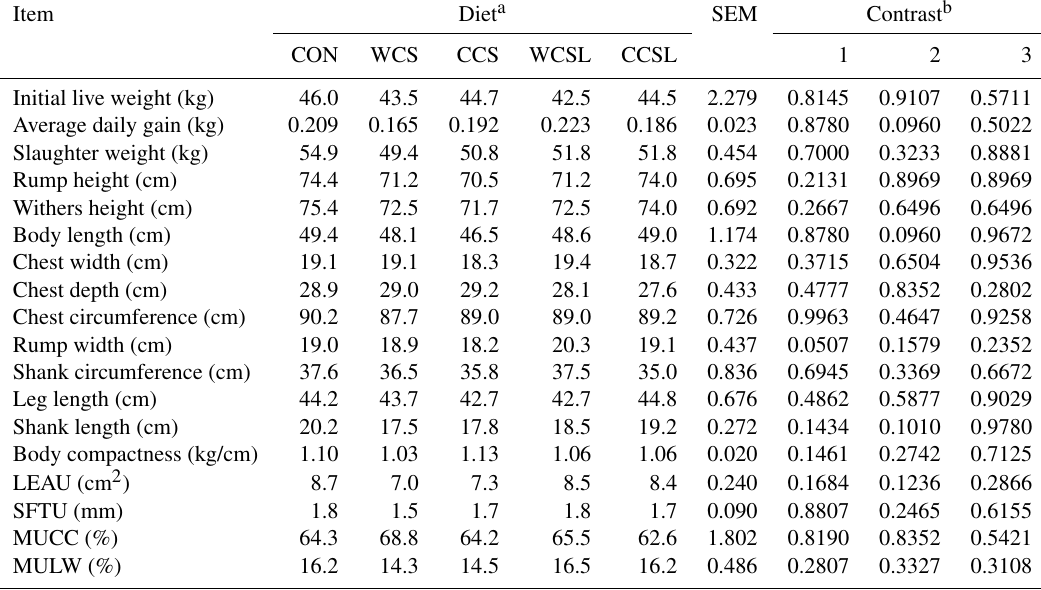
Table 2. Weight gain, biometric measurements, subcutaneous fat thickness (SFT), and loin-eye area (LEA) of the longissimus muscle and body capacity obtained in vivo by ultrasound in Santa Inês cull ewes fed high-concentrate diets with cottonseed associated with calcium